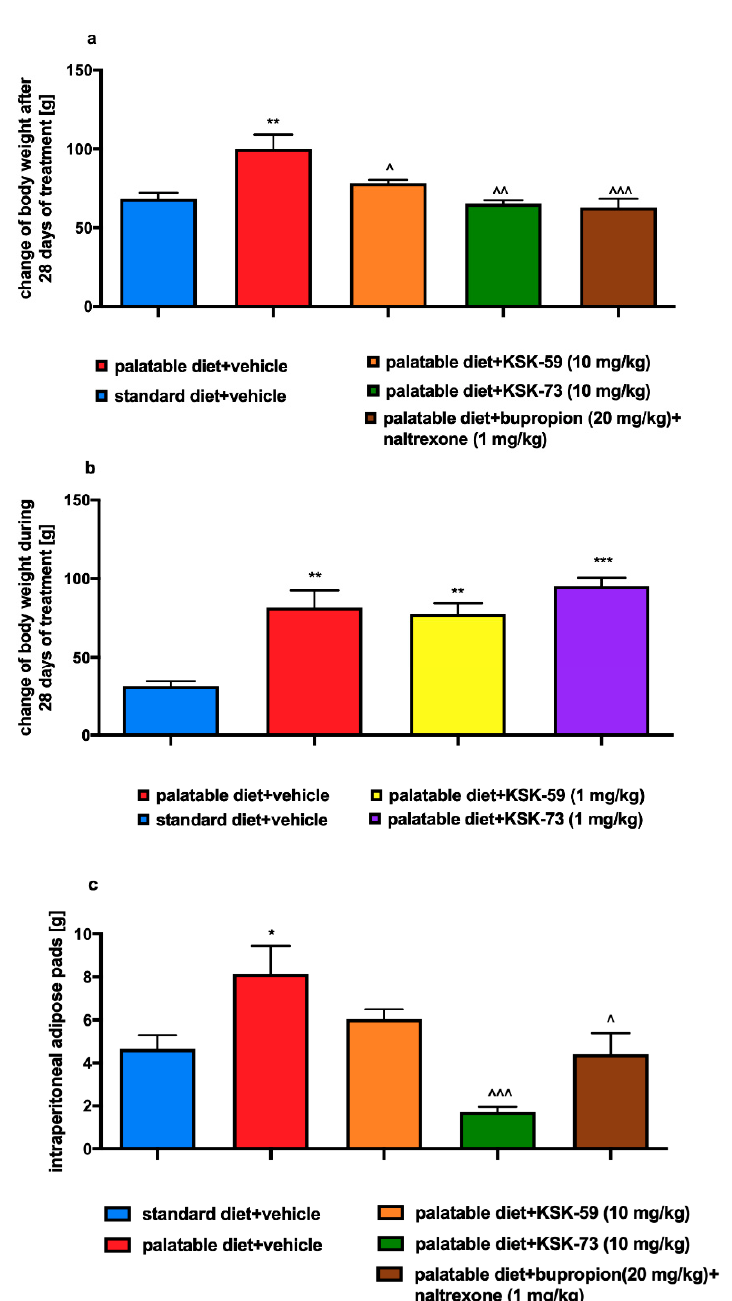
Figure 3. Cumulative changes in body weight and mass of adipose pads. ( a , b ) Cumulative changes in body weight. ( c ) Mass of adipose pads at the end of experiment. Results are expressed as means ± SEM, n = 6. Comparisons were performed by one-way ANOVA, Tukey’s post hoc tests. * Significant against control rats fed standard diet; ^ significant against control rats fed palatable diet; ^, * p < 0.05, **, ^^ p < 0.01, ***, ^^^ p < 0.001.